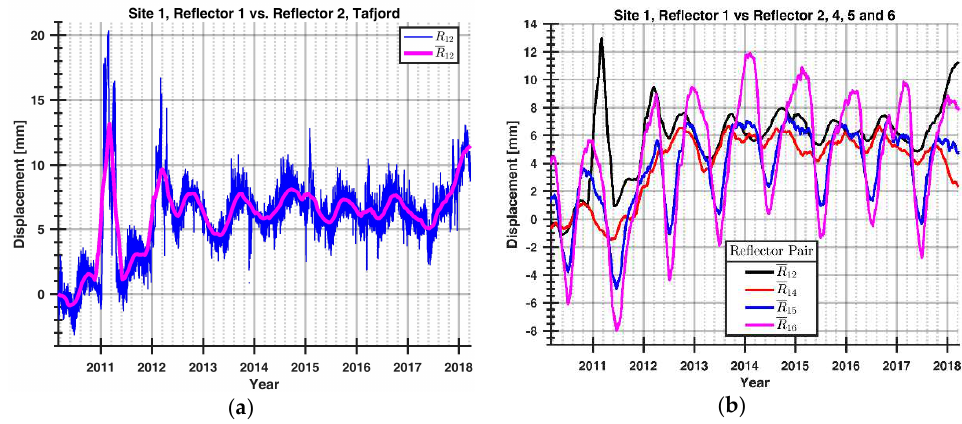
Figure 15. ( a ) The displacement as a function of time for Site 1, reflector 1 referenced to reflector 2. There are three large displacements visible in the plot during the winters of 2011, 2012, and 2018. All three displacements are believed to be caused by build-up of snow inside the reference reflector. The blue line is the raw-data, while the magenta line is the 3-month moving mean. ( b ) The displacement of reflector 1 at Site 1 referenced to all the reference reflectors. They all show similar motion, the major difference being the variation in the amplitude of the annual cyclic motions. The variation in amplitude increases with the distance between reflector 1 and the reference